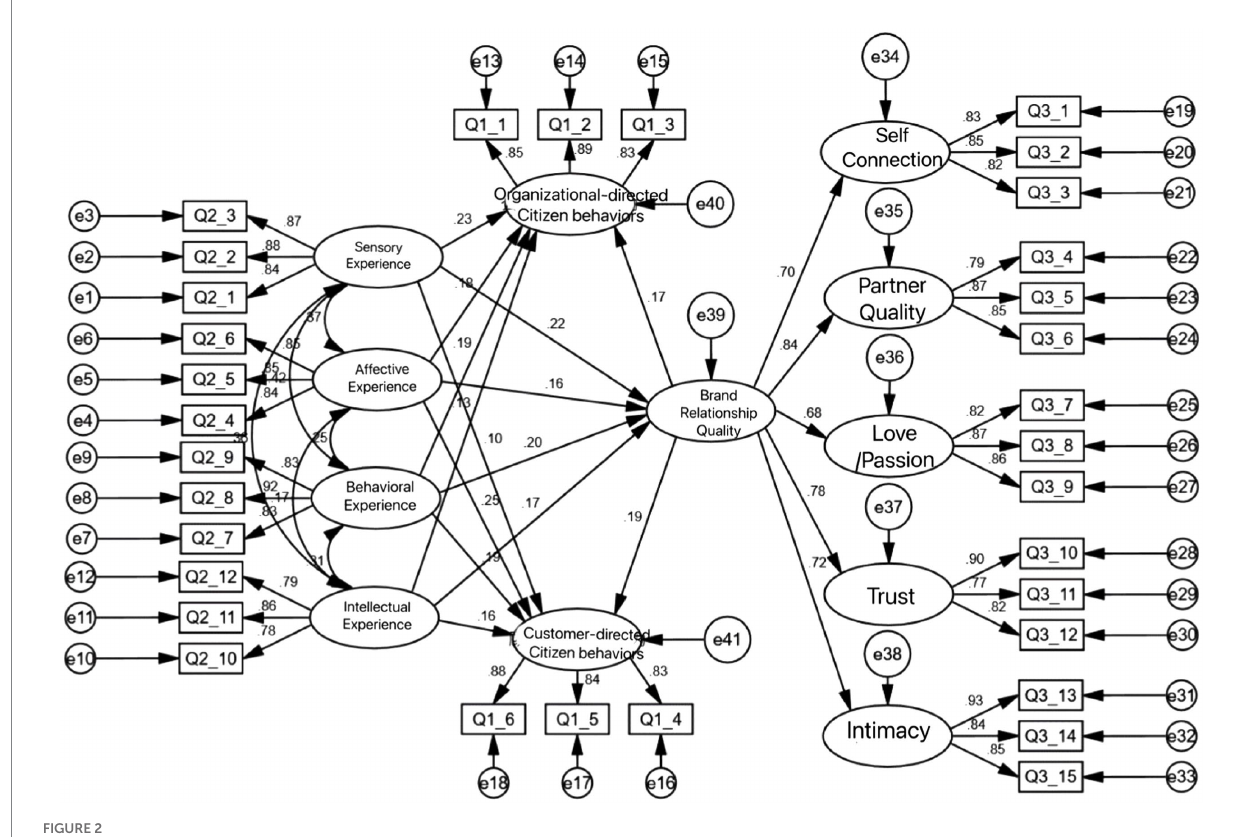
FIGURE 2 Structural equation path model.